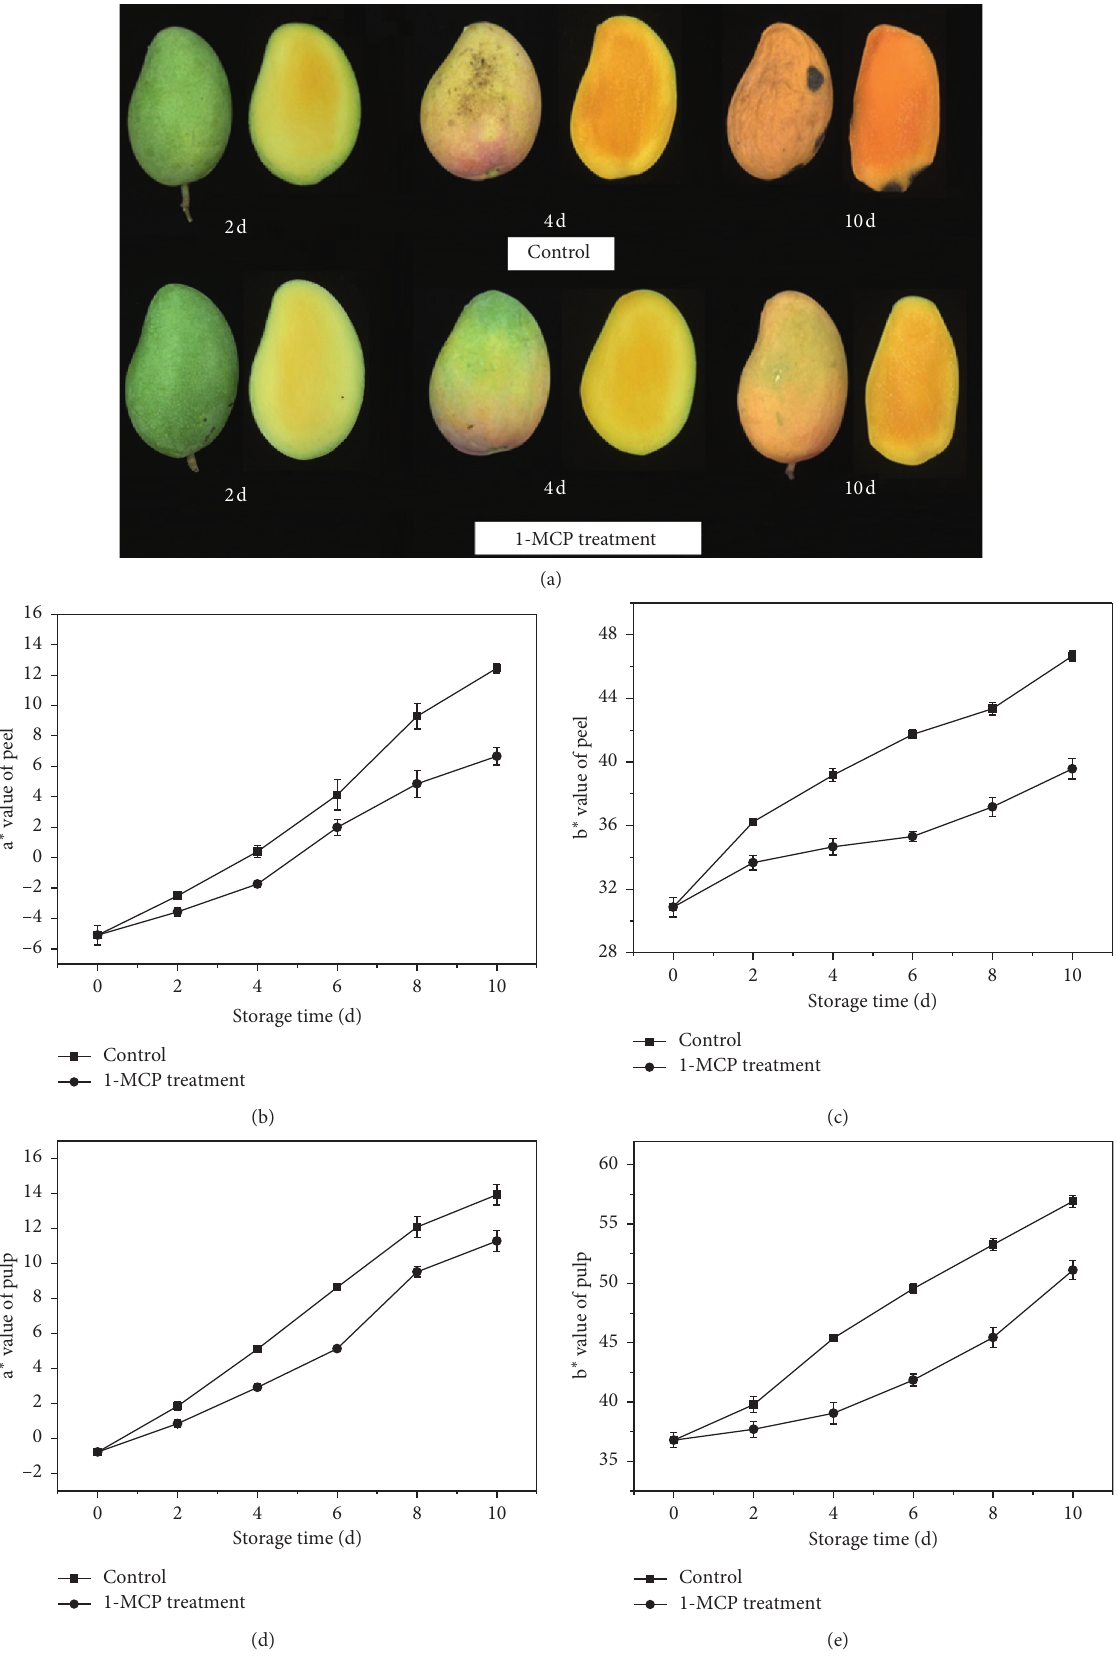
Figure 2: Effects of 1-MCP treatment on colour (a), a ∗ value (b) and b ∗ value (c) of peel, and a ∗ value (d) and b ∗ value (e) of pulp of mango during storage at 25 ° C. The data are the means of triplicates ± standard